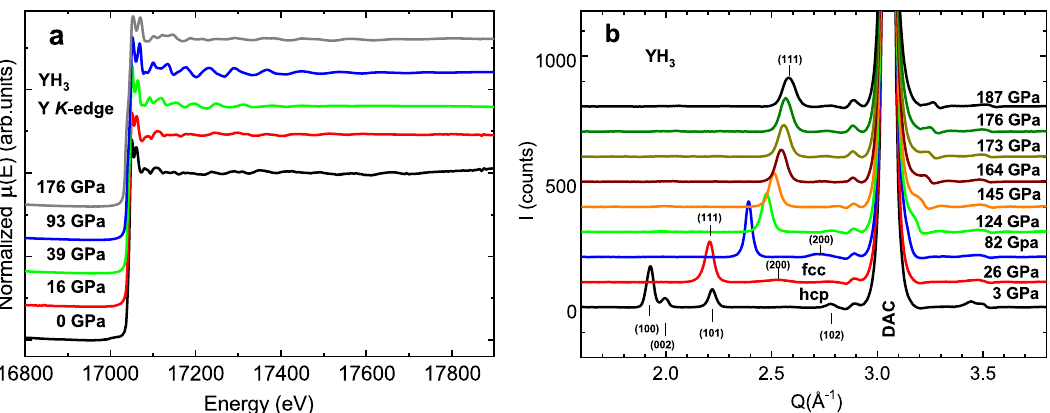
Fig. 1 Pressure-dependent XAS and XRD of YH 3 . a The normalized X-ray absorption spectra of YH 3 , measured above the Y K -edge at different pressures up to 176 GPa; b The pressure dependence of the X-ray diffraction patterns for YH 3 .